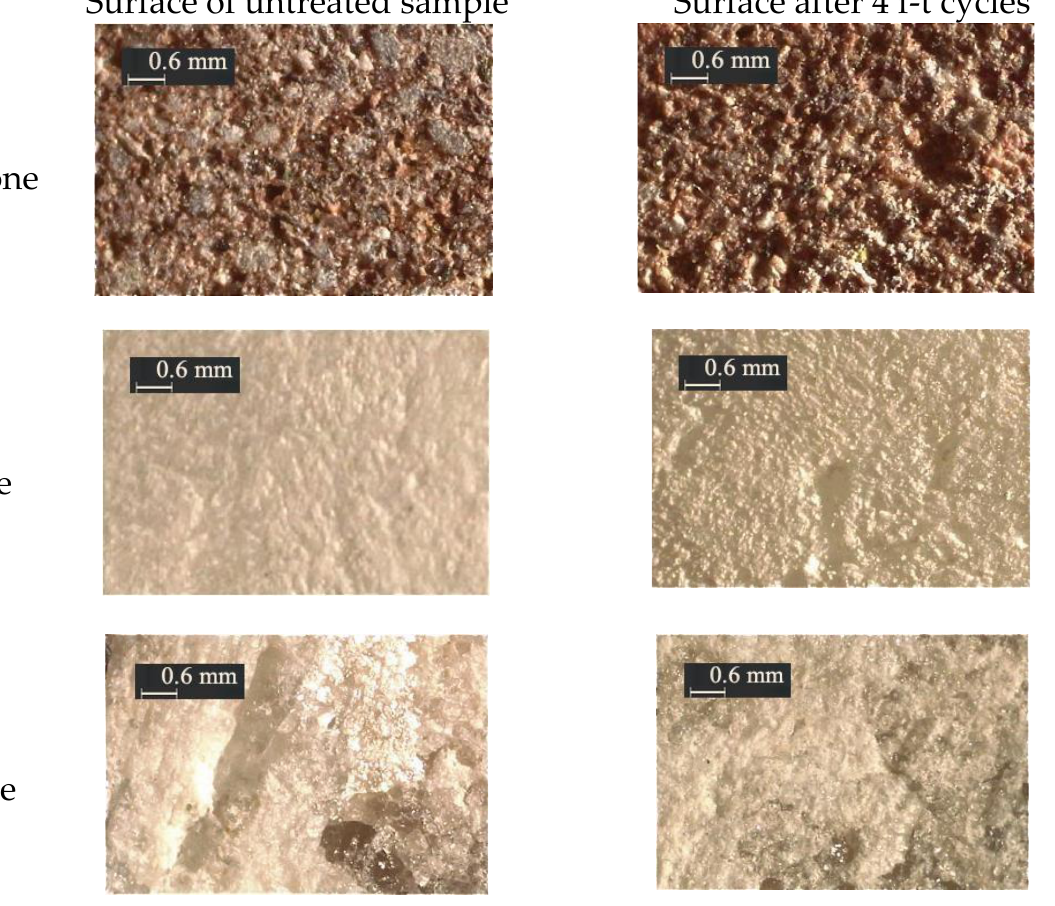
Figure 9. Sample surface observed under stereomicroscope.